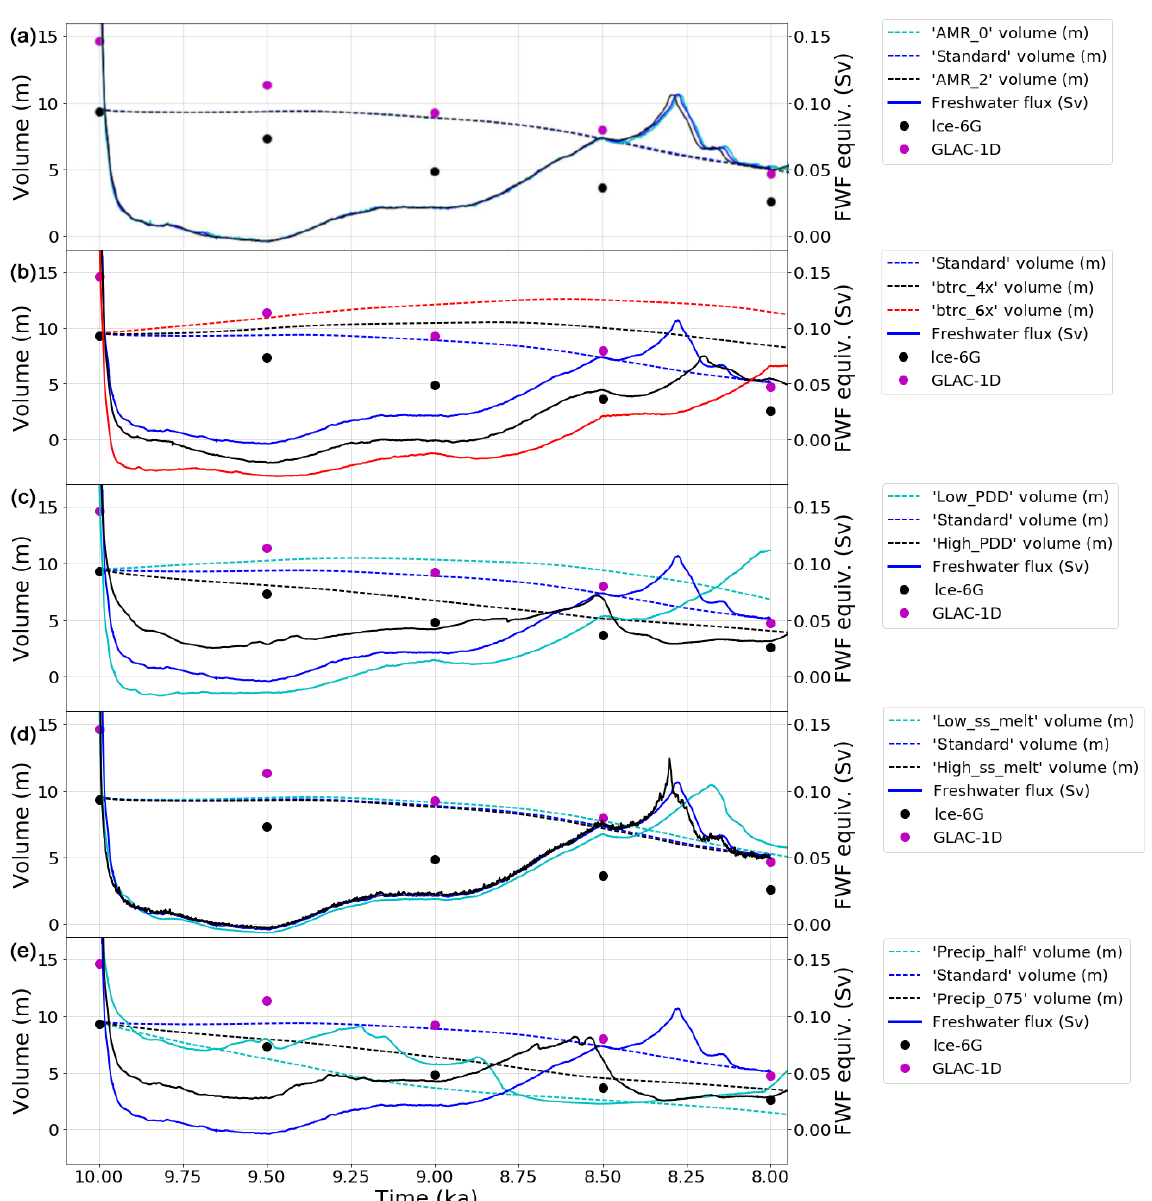
Figure 6. Effects of varying (a) adaptive mesh resolution, (b) basal traction coefficient C , (c) PDD (positive degree day coefficients), (d) sub- shelf melting rate, and (e) precipitation on simulated ice sheet volume in metres of sea level rise equivalent and freshwater flux equivalent in sverdrups. The black and magenta markers show the volume in metres of equivalent sea level rise (SLR) in the ICE-6G_c (VM5a; Peltier et al., 2015) and the GLAC-1D (Tarasov et al., 2012)